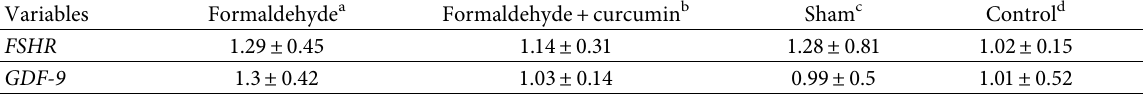
Table 2: Comparison of relative gene expression profles among study groups.